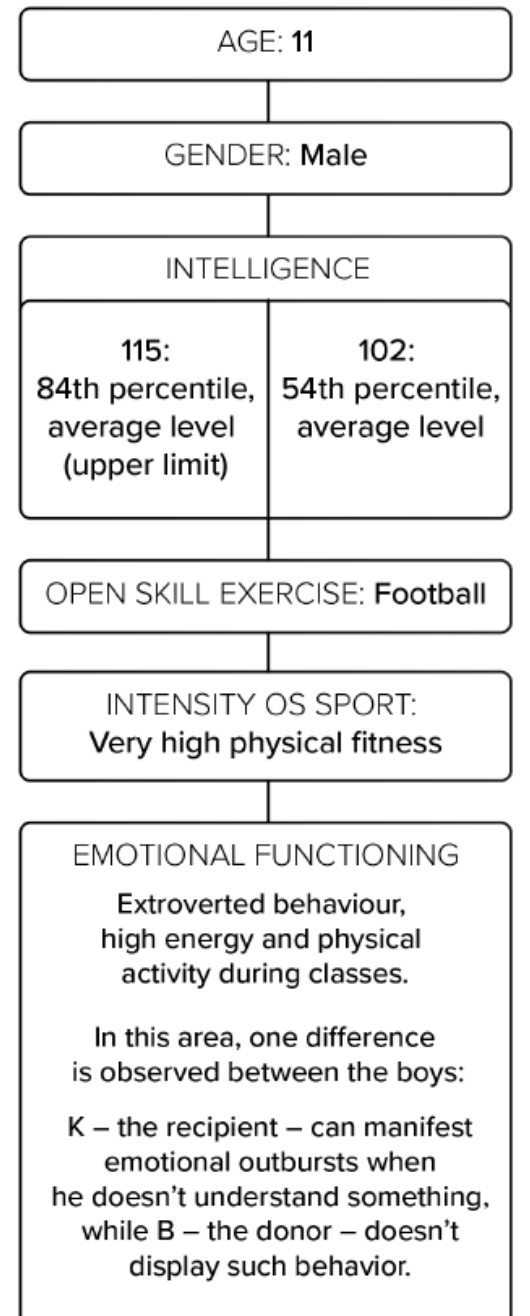
Figure 1. Author’s “hypothetical model” of the impact of individual elements by children after TTTS (twin-to-twin transfusion syndrome) on cognitive